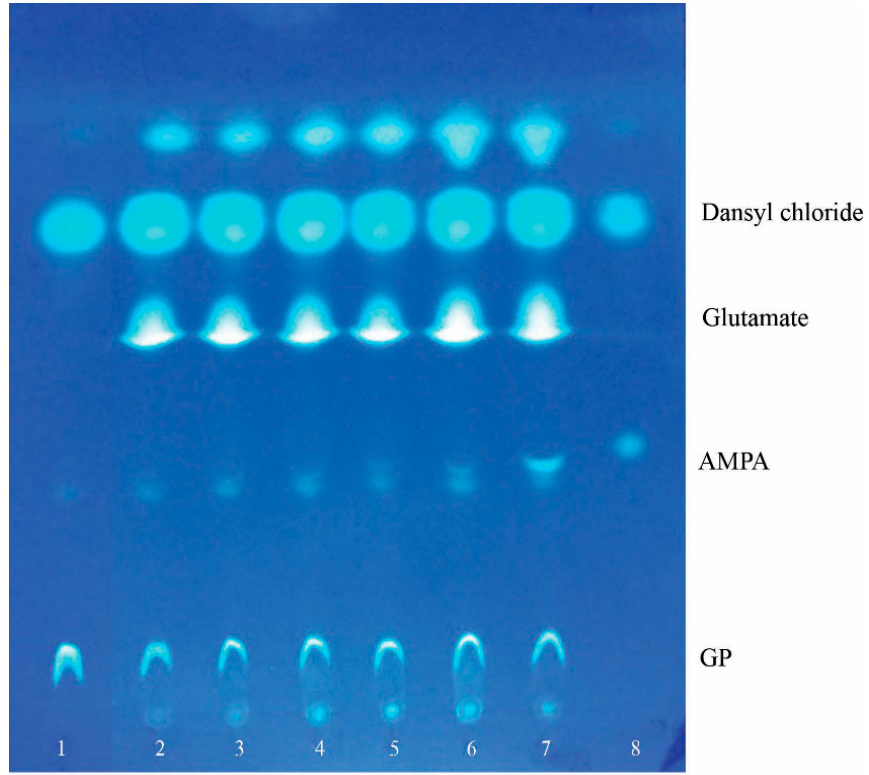
Figure 4. Mobility of dansyl derivatives of glyphosate and its transformation products that are present in the culture liquid of P. putida strain Ch2: 1—GP, 2–6—the culture liquid; 2—start